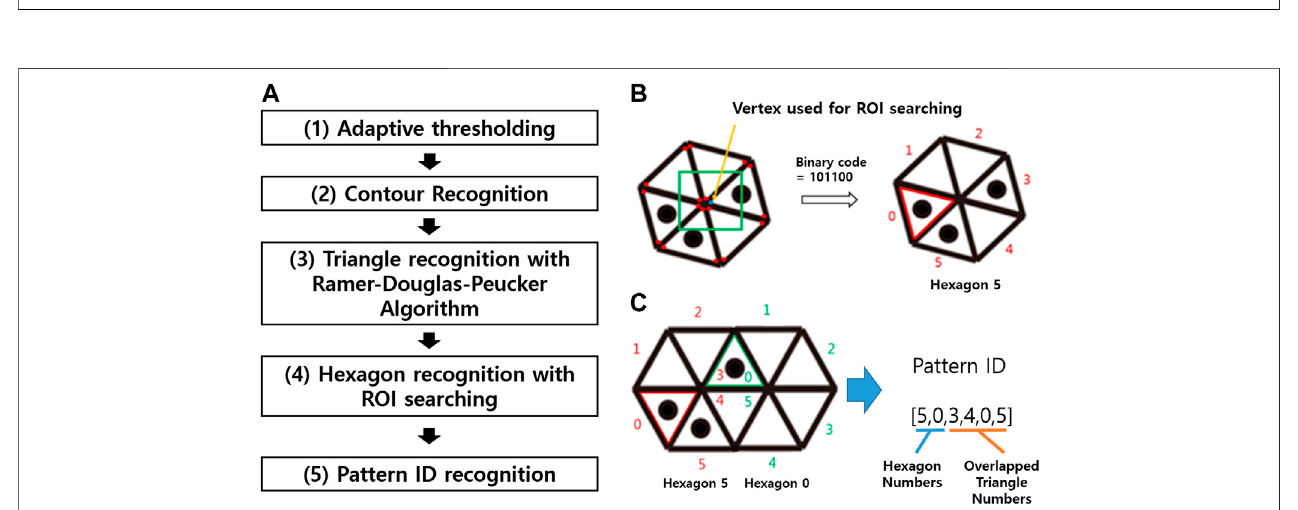
FIGURE3|(A) PatternIDsimplemented intheWSM system.Note thatradiallysymmetricpatternswereavoided withinasinglehexagon. (B) Atotalof384pattern IDs can be used when two adjacent hexagons are used to compose an ID.